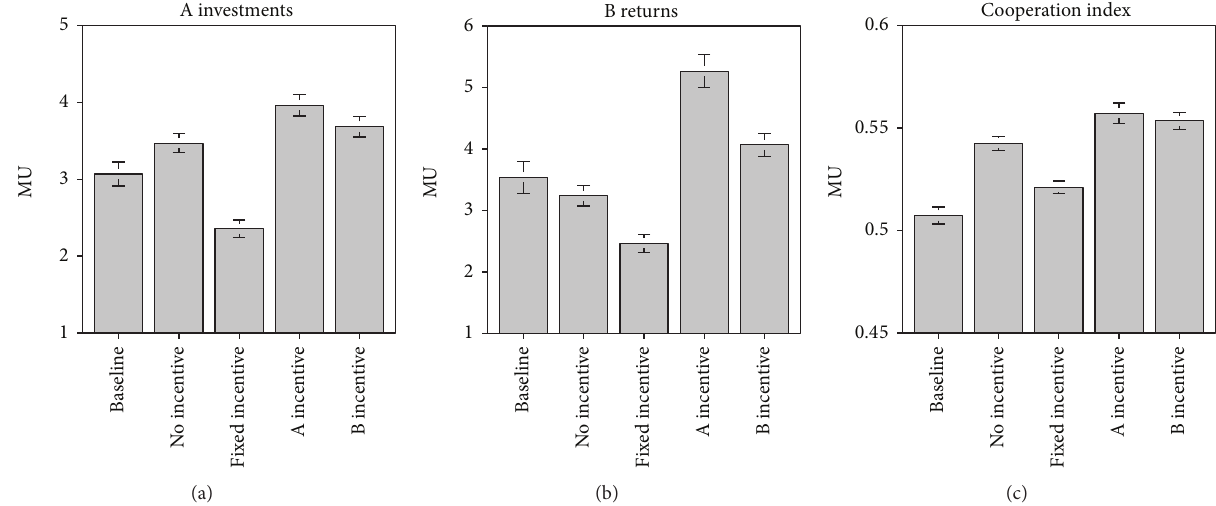
Figure 2: Experiment 2 results. Average investments, returns, and CI by treatment. Bars show the standard error of the means.